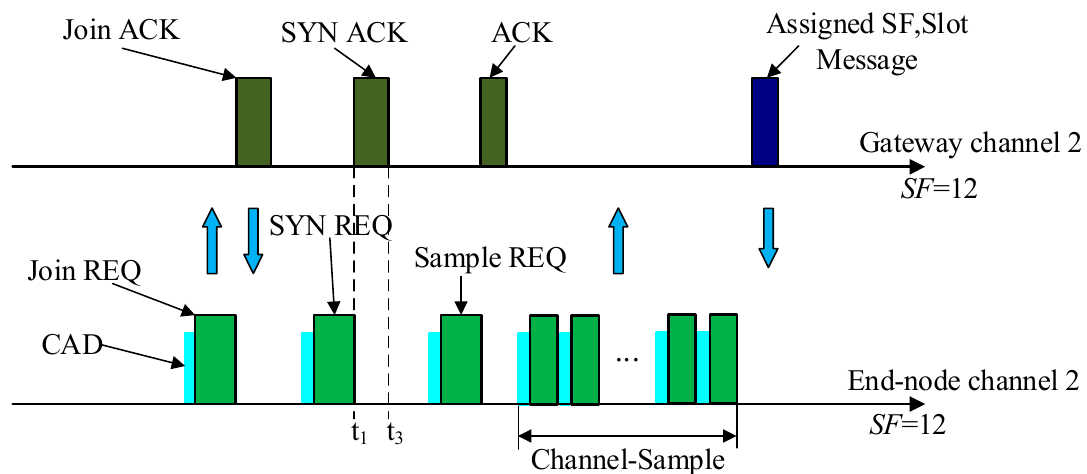
Figure 10. End-nodes join the network on channel 2.